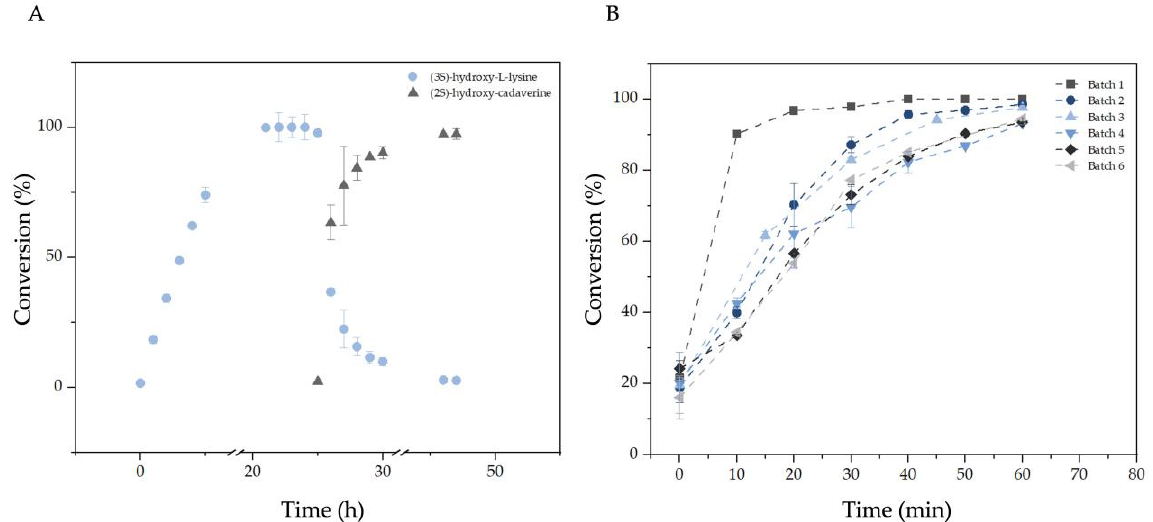
Figure 8. Two-step cascade reaction towards (2 S )-hydroxy-cadaverine using Ca KDO-HaloTag ® and Sr LDC-HaloTag ® and repetitive batch experiments of Sr LDC-HaloTag ® for the production of cadaverine. ( A ) Conversion curves of the sequential cascade reaction of immobilized Ca KDO and Sr LDC in preparative scale. The KDO reaction was performed in a 50 mL shaking flask without baffles in a reaction volume of 15 mL, at 20 °C, and 1.3 mg mL −1 HaloTag ® -immobilized Ca KDO. Reaction conditions: 100 mM L - lysine, 150 mM α -KG, 2.5 mM L -ascorbic acid, 0.01 mM DTT, and 1 mM (NH 4 ) 2 Fe(SO 4 ) 2 for 25 h, at 150 rpm orbital shaking. Afterwards, the reaction supernatant was transferred to a 50 mL falcon tube; the pH was titrated to 7.0; 1 mM PLP was added. The second reaction was started with 2.5 mg mL −1 HaloTag ® -immobilized Sr LDC. The reaction was run for another 22 h in an overhead shaker at 35 °C under the exclusion of light. ( B ) Repetitive batch reactions of HaloTag ® -immobilized Sr LDC. Reaction was performed in a 50 mL falcon tube, in a reaction volume of 15 mL and 1 mg mL −1 HaloTag ® -immobilized Sr LDC starting from 100 mM L -lysine, in 100 mM HEPES, pH 7.0, with 1 mM PLP in an overhead shaker at 35 °C under exclusion of light. After each batch, the immobilized catalyst was separated by centrifugation, washed 4 times with 100 mM HEPES, pH 7.0, and used for the next reaction. Error bars are the result of two independent immobilizations.